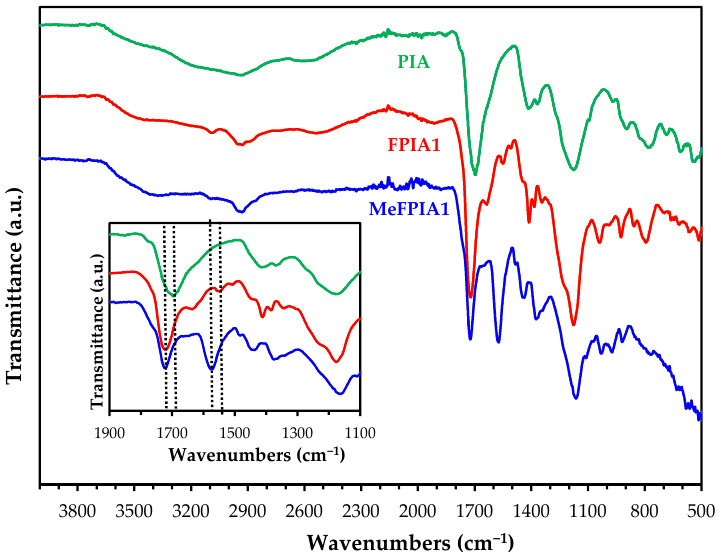
Figure 2. Fourier transform infrared (FTIR) spectra of PIA, modified FPIA1, and quaternized MeFPIA1 polymer.